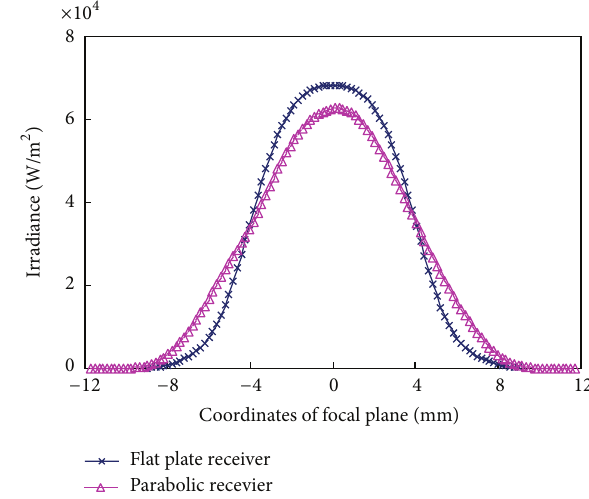
Figure 15: The radiant flux density on the surface of parabolic receiver and flat